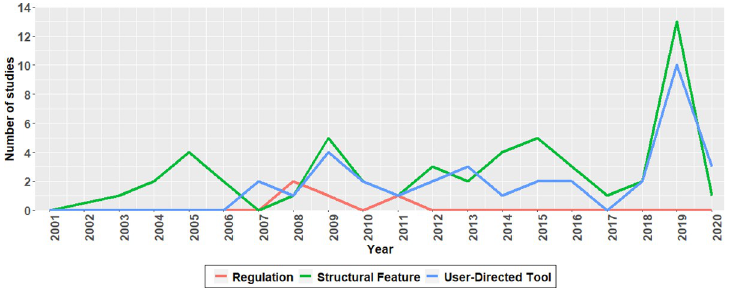
Fig 2. Yearly counts of studies on structural features, user-directed tools, and regulations. 2020 only includes studies through